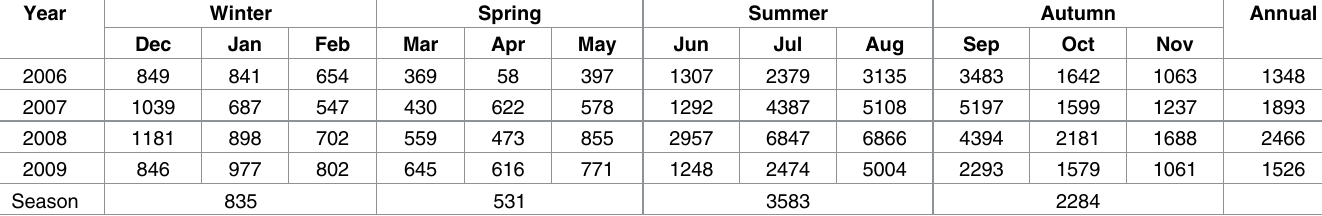
Table 4. Simulated monthly streamflow at Nuxia hydrological station from 2006 to 2009 (m 3